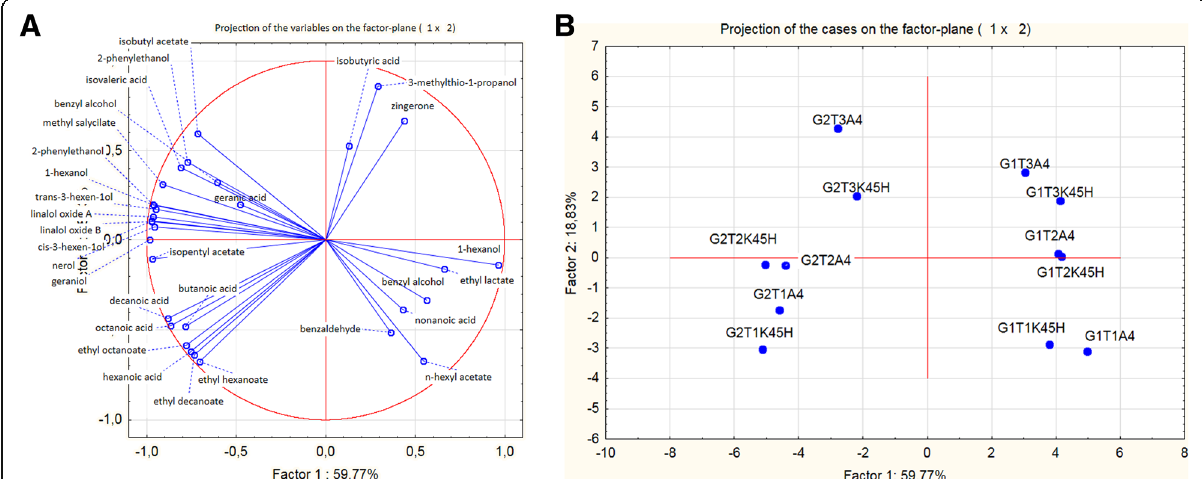
Fig. 4 PCA analysis of the main represented volatile compounds that characterized wines obtained by yeast/bacteria simultaneous fermentation at different temperature profiles (mean data, n = 3). Experiments were performed in two different grape must (G1 and G2) at 3 temperature profiles. T1 test: 16/22 °C in 3 days, B. T2 test: 18/24 °C in 3 days, and C . T3 test: 22/32 °C in 5 days. a Projection of variables in the plain 1 × 2. b Distribution of cases in the plain 1 ×